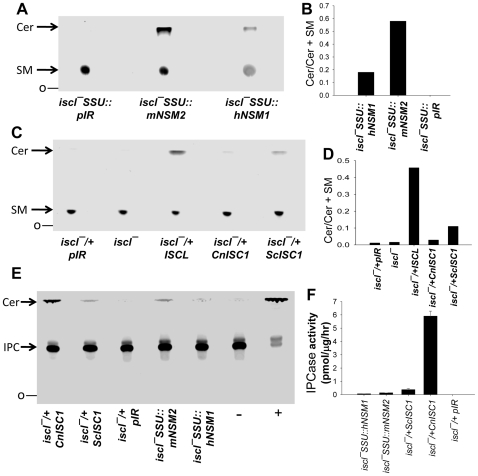
Heterologous expression of mammalian neutral SMases and fungal ISC1ps in iscl−.(A)–(B) Iscl− parasites with human neutral SMase 1 (iscl− SSU::hNSM1), murine neutral SMase 2 (iscl− SSU::mNSM2), or pIR1SAT vector only (iscl− SSU::pIR) were labeled with NBD-sphingomyelin and lipids were examined as described in Fig. 4C. (C)–(D) Similar experiments were performed using iscl− parasites transfected with pIR1SAT-ScISC1 (iscl−/+ScISC1), pIR1SAT-CnISC1 (iscl−/+CnISC1), and pIR1SAT vector only (iscl−/+pIR). To evaluate the degradation of NBD-sphingomyelin, ratios of ceramide/ceramide + sphingomyelin were determined using an Image Analysis Software (ImageQuant TL 7.0) and shown in B and D. (E) IPC degradation assay was performed using whole cell lysates from iscl− parasites transfected with hNSM1, mNSM2, ScISC1, or CnISC1; results were normalized to pmol/mg/hour (F). Positive control (+): 0.1 unit of B. cereus PI-PLC; negative control (−): boiled WT lysate. Experiments were repeated multiple times and error bars represent standard deviations.